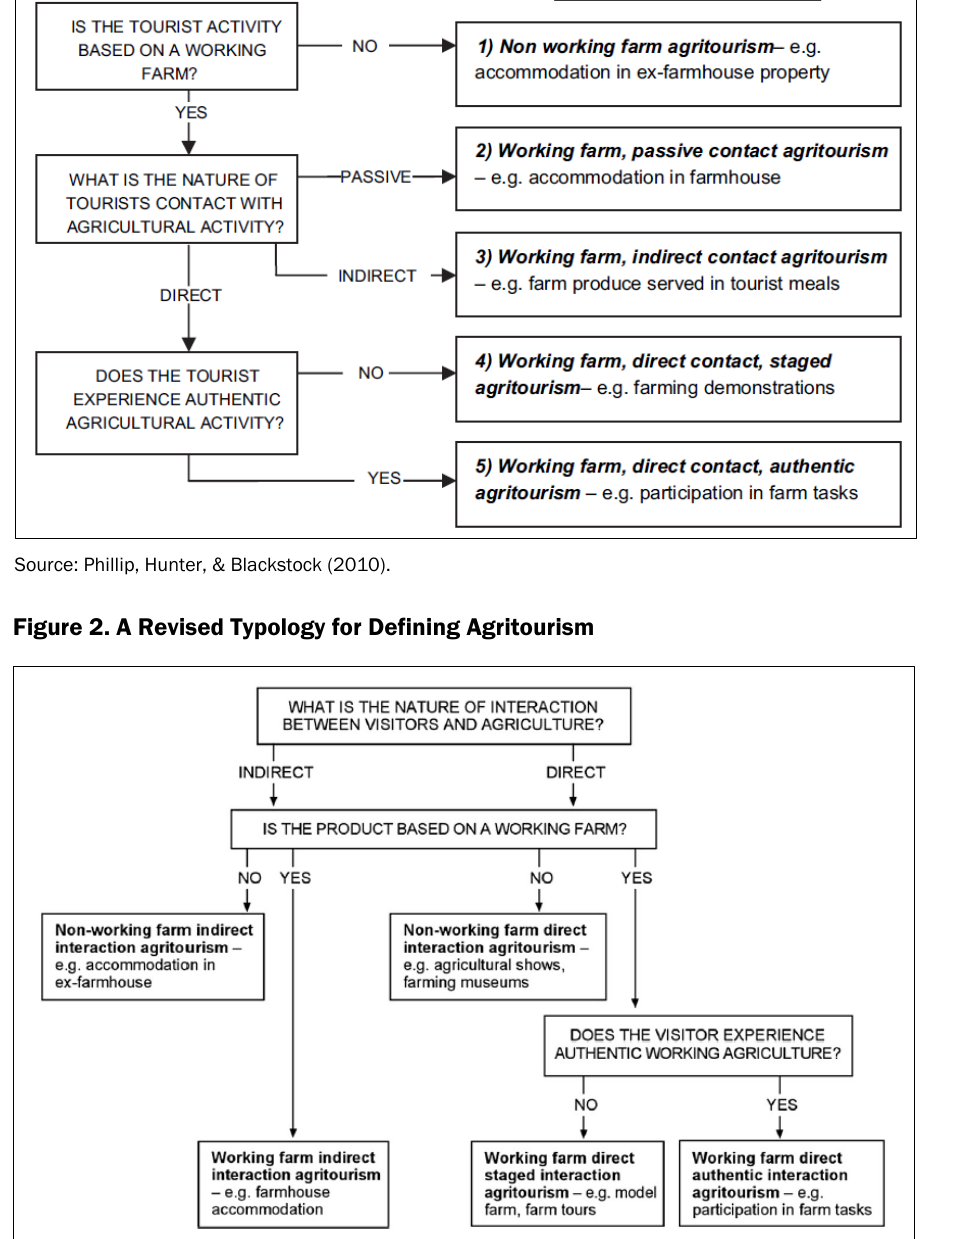
Source: Flanigan, Blackstock, & Hunter (2014).